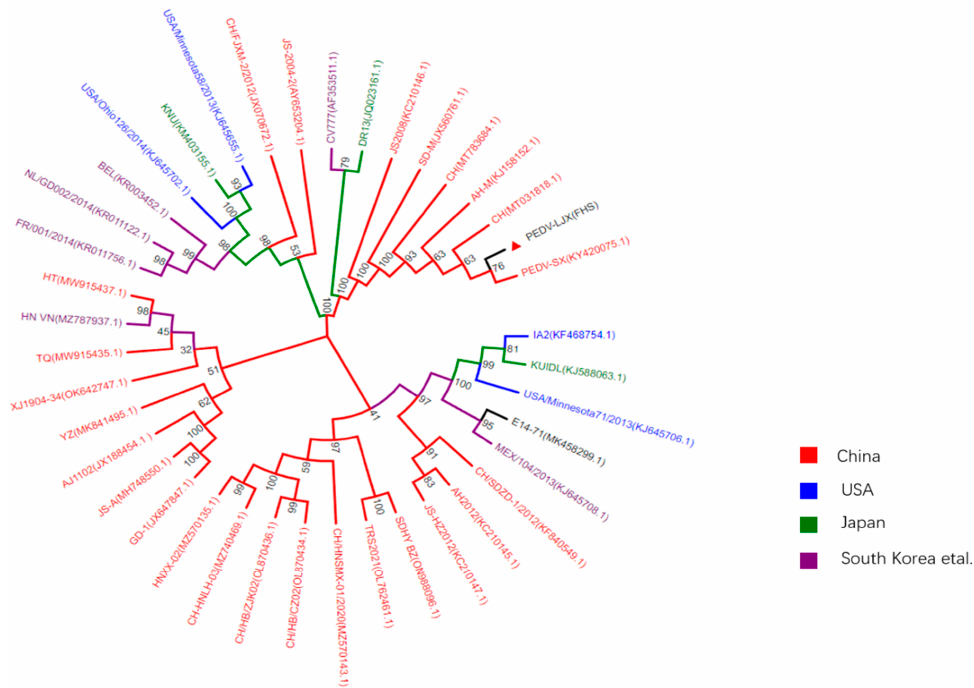
Figure 4. Phylogenetic analysis based on the S genes from different PEDV strains. The phylogenetic tree was constructed from the aligned nucleotide sequences using the neighbor-joining method with MEGA11 and EvolView software. Reference sequences obtained from GenBank are indicated by their strain names and GenBank accession numbers. The S gene of the PEDV-LJX strain infecting FHs 74 Int cells is indicated by the red triangle.